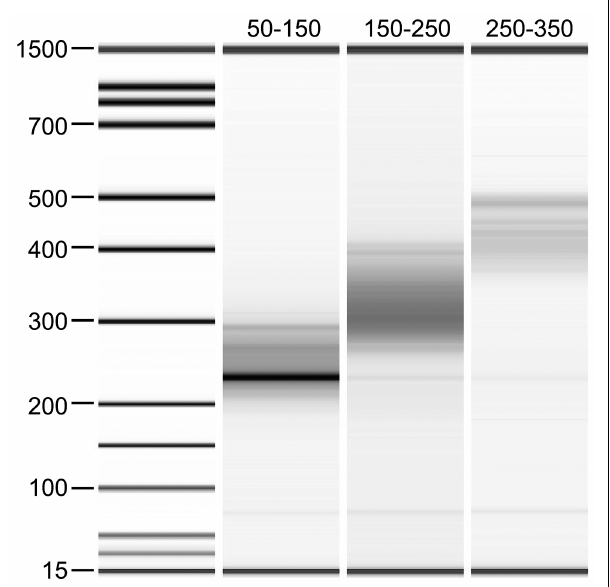
FIGURE 2 | Bioanalyzer gel image of the three RRBS libraries made with different insert sizes. Ligated adapters cause the DNA fragments to migrate to a higher molecular weight (approximately 100 bp higher) than the insert sizes